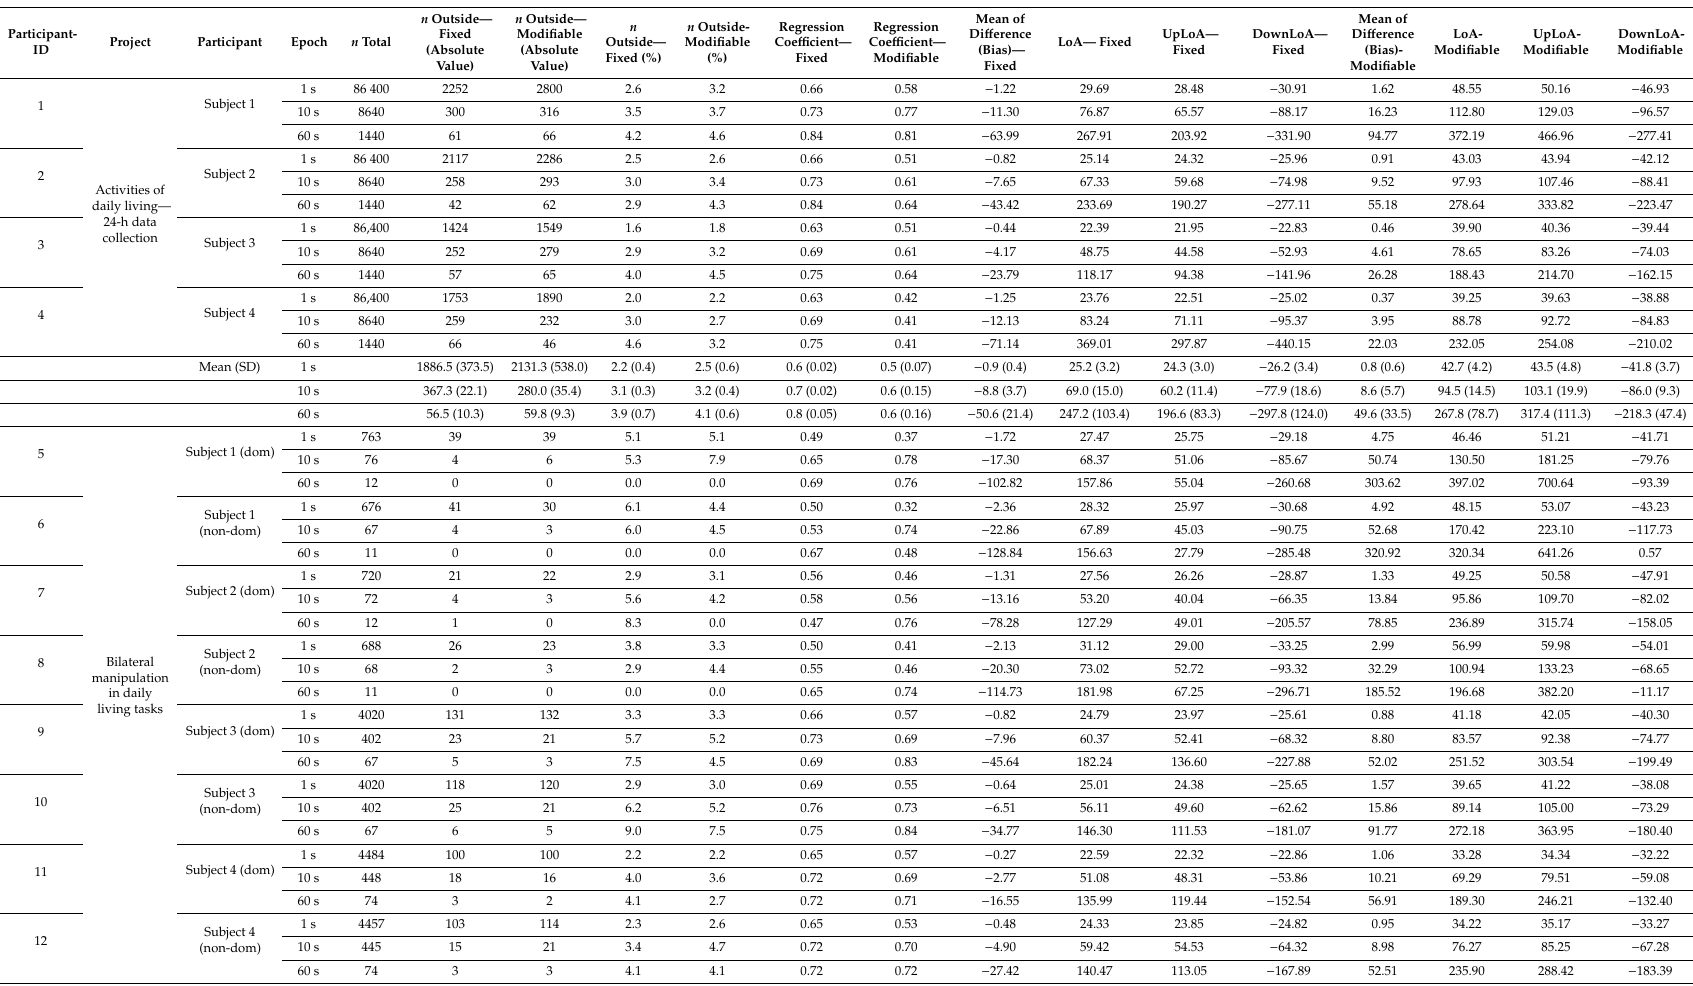
Table A2. Number of data points outside of the limits of agreement, regression coe ffi cient, mean di ff erence, upper and lower limits of agreement for the fixed and the modifiable algorithm for epochs of 1 s, 10 s, 60 s. “s” stands for